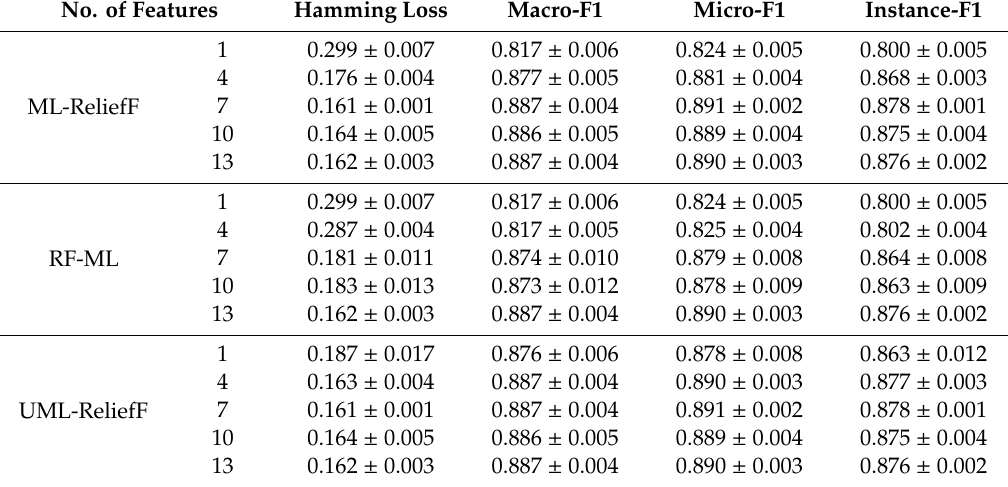
Table 3. Experimental results of KQI prediction with unweighted ML-kNN ( k = 15, L = 14).